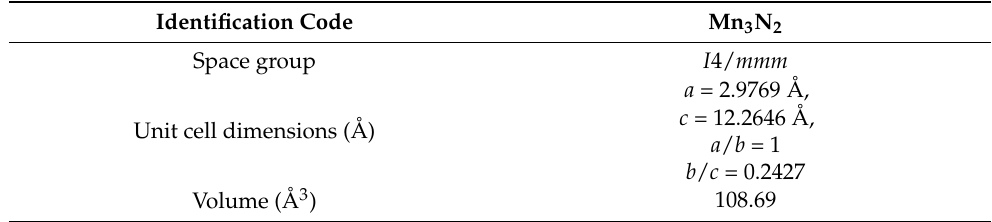
Figure 1. Powder (R3C4) XRD test pattern of crystal. × is the test value of the experiment, the red line is the calculated fitting value, and the blue line is the difference between the two. Table 1. Experimental data and crystal details obtained from Rietveld refinement.